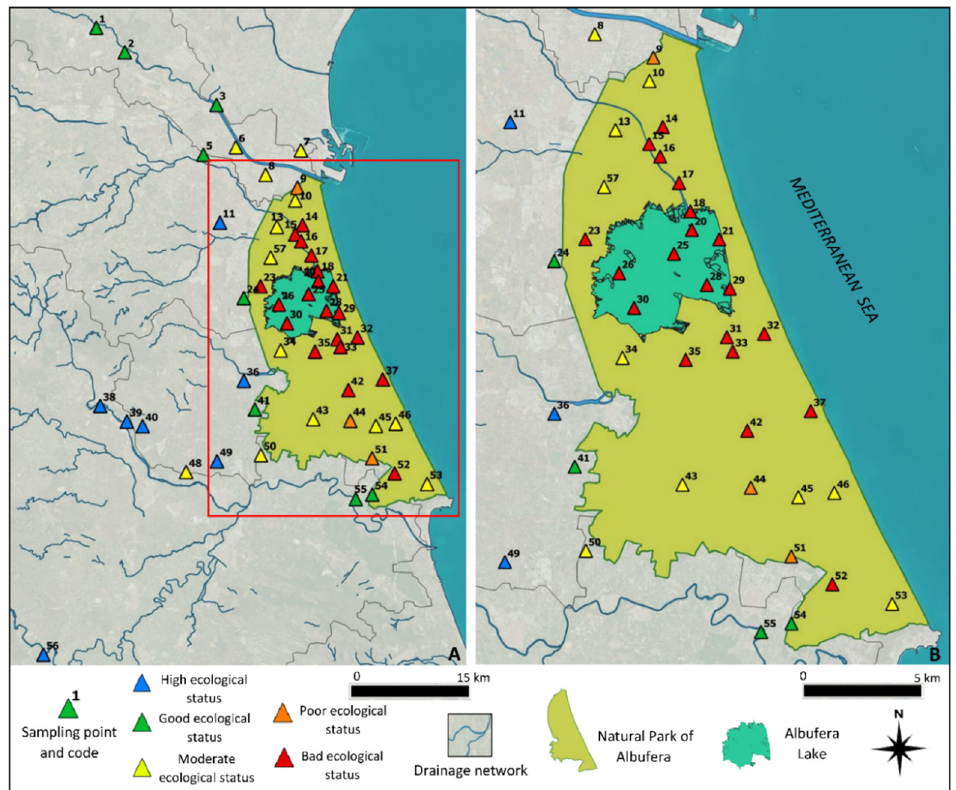
Figure 6. Study area and spatial distribution of the sampling points classified according to their ecological potential [24,70]. Results for ( A ) entire study area, ( B ) natural park area. Base image: OrtoPNOA 2018 CC-BY 4.0 scne.es.